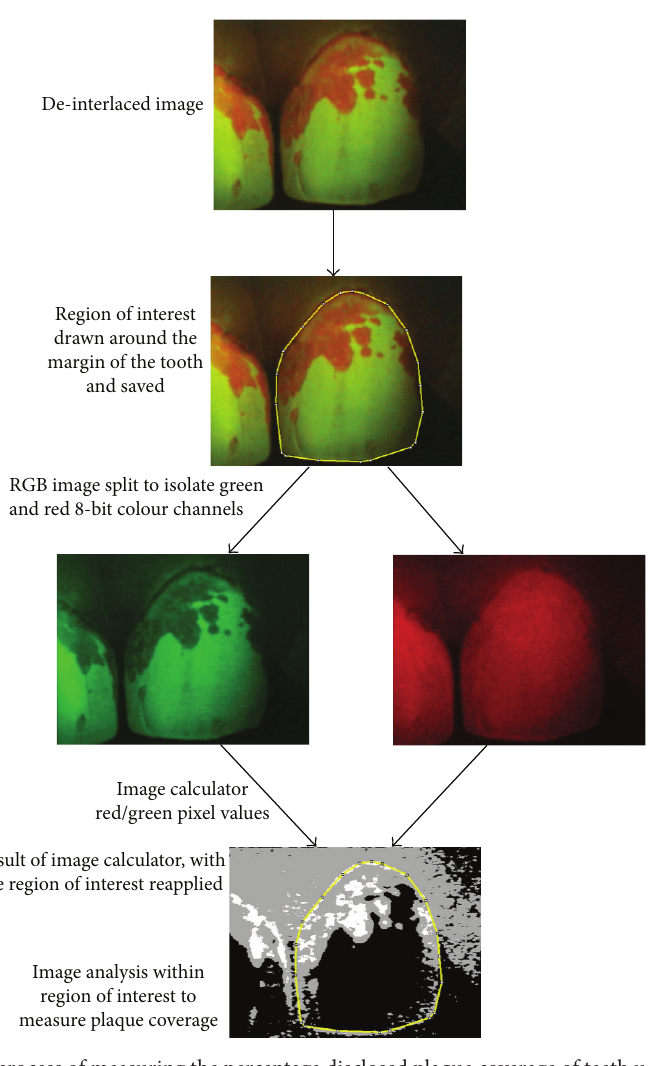
Figure 1: The process of measuring the percentage disclosed plaque coverage of teeth using ImageJ.